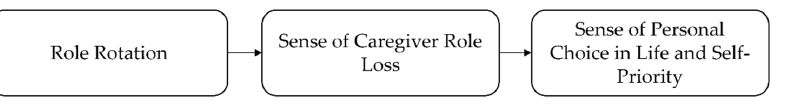
Table 6. Practical implications to the family